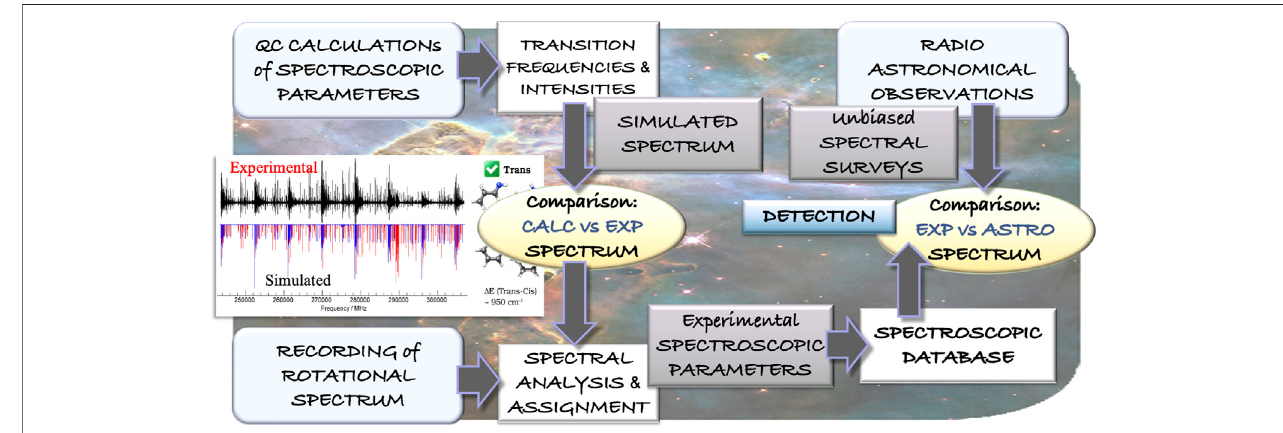
FIGURE 4 | Schematic representation of the interplay of theory and experiment in the fi eld of rotational spectroscopy leading to the guidance of astronomical